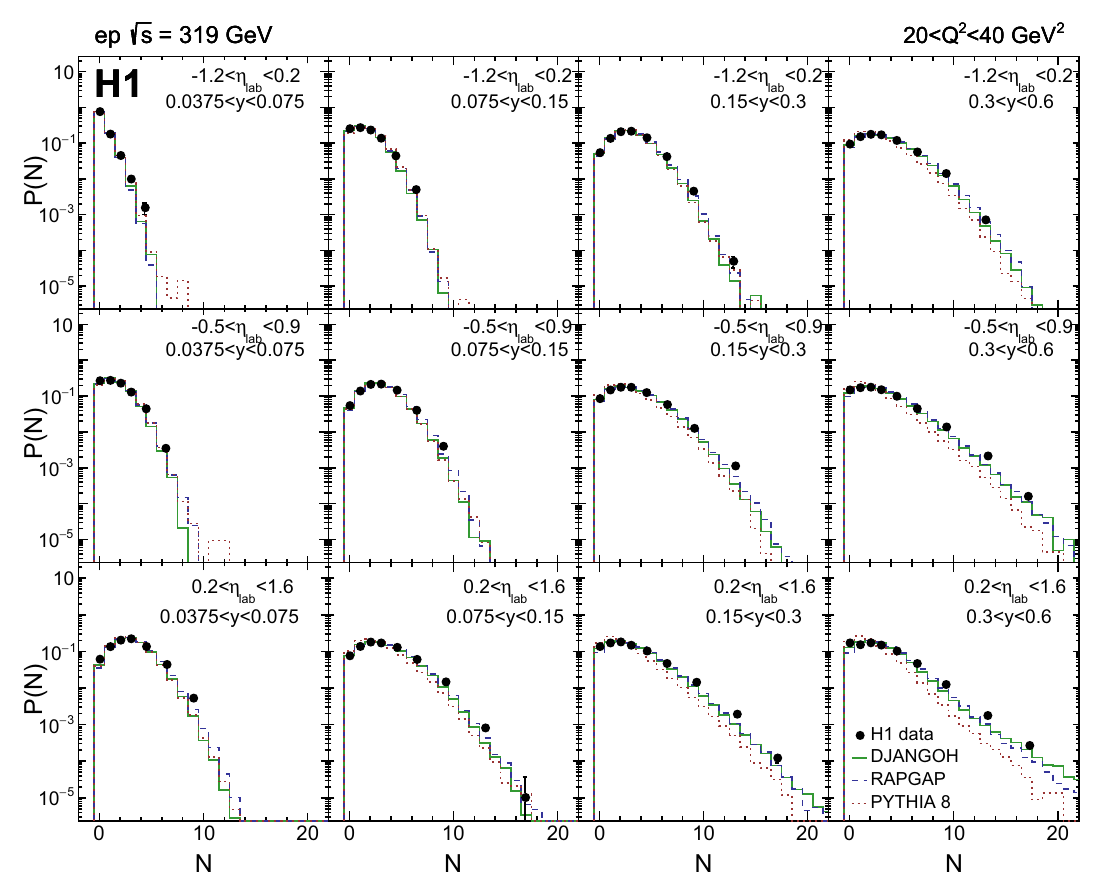
Fig. 5 Charged particle multiplicity distributions P ( N ) as a function indicated by the text in the figure. Predictions from DJANGOH, RAP- √ s = 319GeV ep collisions in the of the number of particles N at GAP and PYTHIA 8 are also shown. The total uncertainty is denoted range 20 < Q 2 < 40 GeV 2 . Further phase space restrictions are given by the error in Table 1. Different panels correspond to different η and y bins, as lab